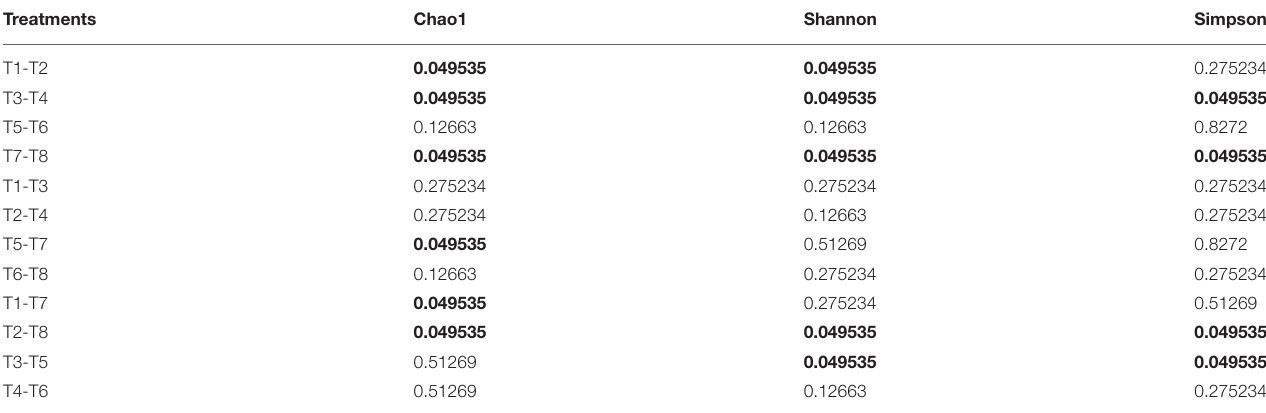
TABLE 2 | The Kruskal–Wallis’ test results ( p -value) of the Alpha index (Chao1, Shannon, and Simpson) of gut microbiome [T1 (DO 6mg L − 1 × pH 8.1 × 20 ◦ C), T2 (DO 6mg L − 1 × pH 8.1 × 30 ◦ C), T3 (DO 6mg L − 1 × pH 7.7 × 20 ◦ C), T4 (DO 6mg L − 1 × pH 7.7 × 30 ◦ C), T5 (DO 2mg L − 1 × pH 7.7 × 20 ◦ C), T6 (DO 2mg L − 1 × pH 7.7